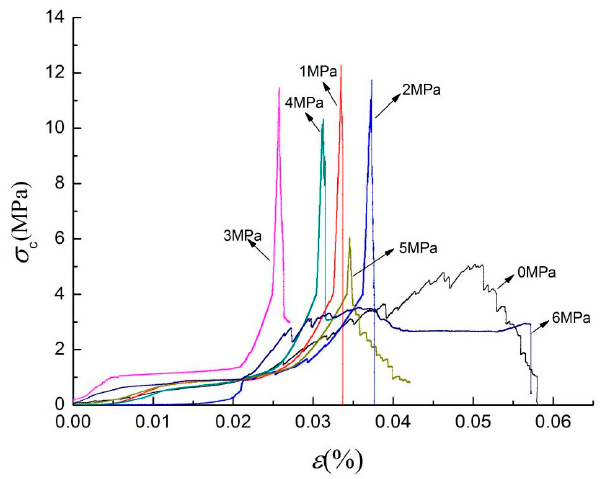
Figure 6. Stress-strain curve of coal samples under varied confining pressure after 3 cycles of liquid nitrogen injection.